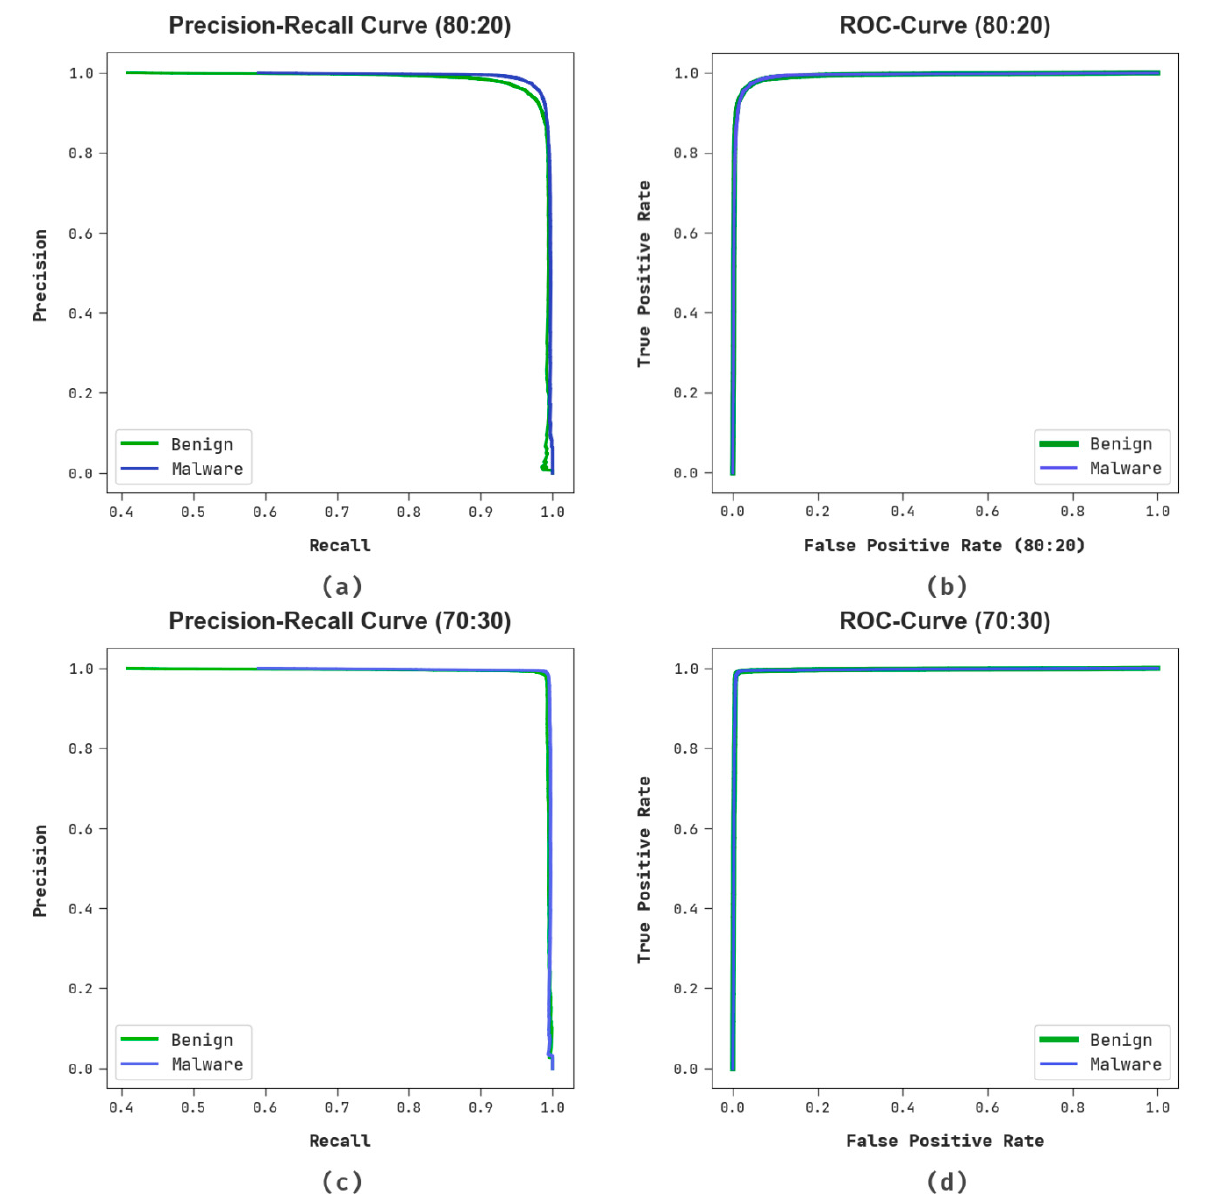
Figure 9. ( a , b ) PR and ROC curve at 80:20 of TRS/TSS and ( c , d ) PR and ROC curve at 70:30 of TRS/TSS.